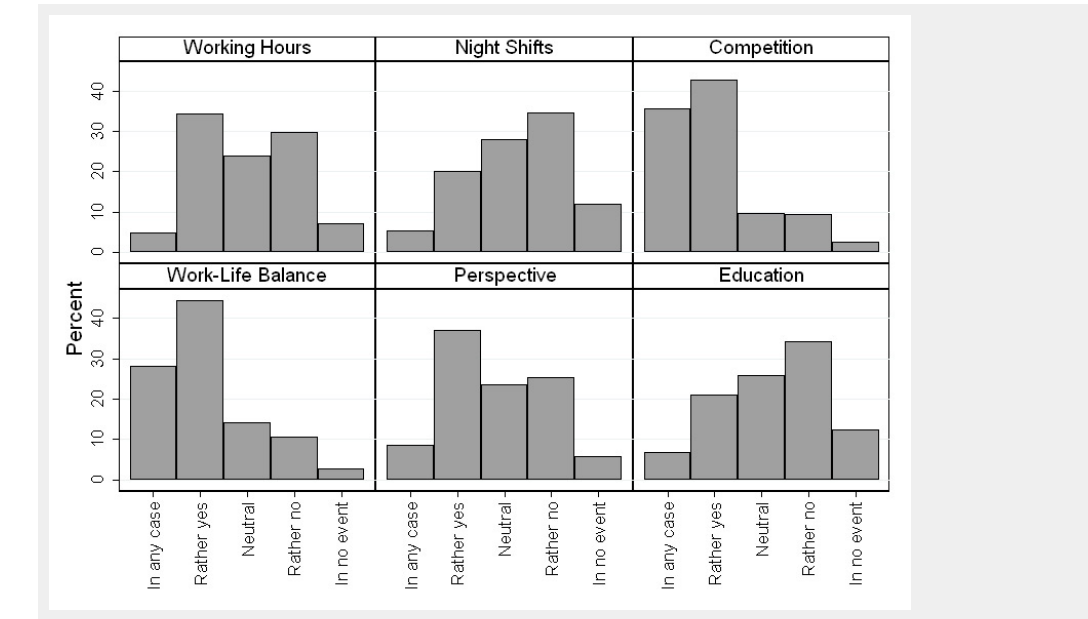
Which aspects of the work environment present a drawback to starting a surgical career: overtime hours (working hours), night shifts, strong competitive mentality inside the team (competition), apprehension of a bad work-life balance (work-life balance), unclear future perspectives (perspective), and lengthy and intensive education curriculum (education)? Please assign a value to each option. (Answering options with five descriptors: in any case – rather yes – neutral – rather no – in no event.)